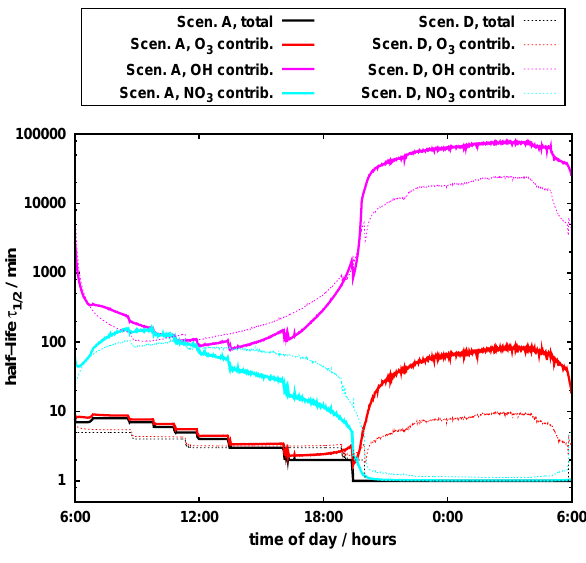
Fig. 4. Evolution of PAH half-life on soot particles in an urban polluted environment during the simulated 24h period (thick, solid lines: scenario A; thin, dotted lines: scenario D). Colored lines show individual contributions to PAH ( ss ) degradation by O 3 , OH, and NO 3 and indicate half-lives calculated according to the ob- served rates of SLR1, GSR1, and GSR2 under the assumption for each of the gases that it was the only reacting